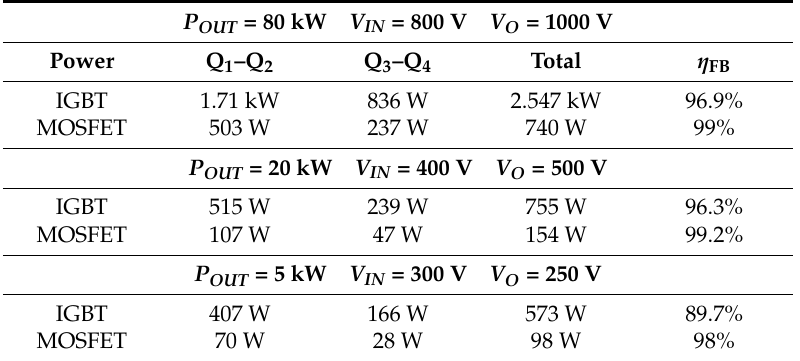
Table 5. Theoretical Power Dissipation in Full Bridge topology.